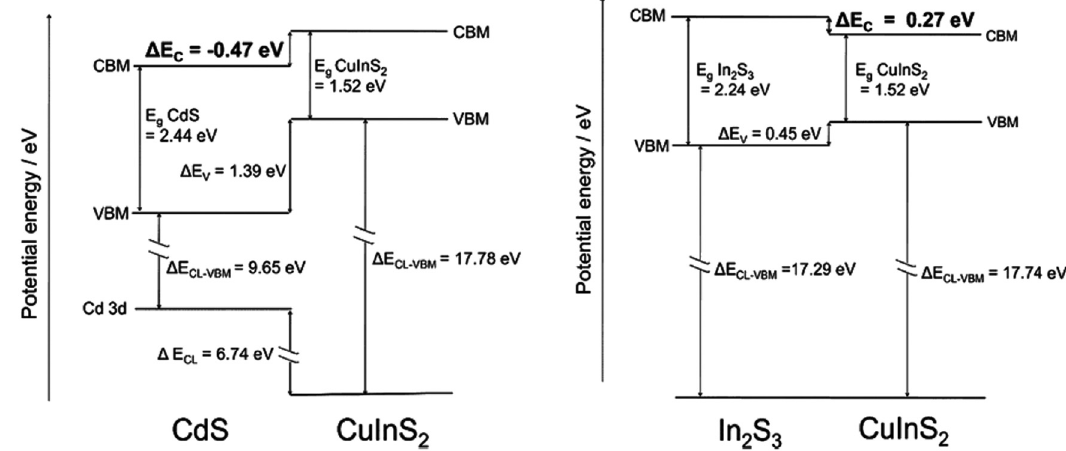
Figure 10: Energy diagrams of CdS/CuInS 2 ( left ) and In 2 S 3 /CuInS 2 ( right ) heterojunctions estimated from photoabsorption and XP spec - troscopy results. Reprinted with permission from ref. [ 29 ] . ©2015 American Chemical